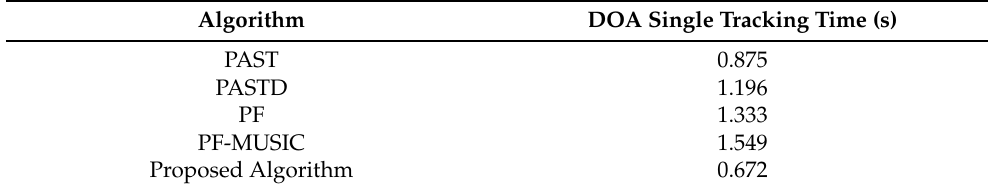
Figure 4. RMSE performance versus SNR for DOA tracking. Simulation setup: single vehicle; the number of ultrasonic array elements is 16 on the RSU array. ( a ) The vehicle speed is 90 km/h. ( b ) The vehicle speed is 150 km/h. Table 1. DOA single tracking time for different algorithms when the number of array elements is